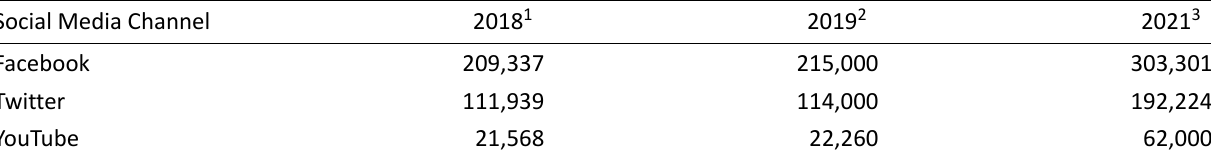
Table 1. Followers and subscribers of Mada Masr on Facebook, Twitter, and